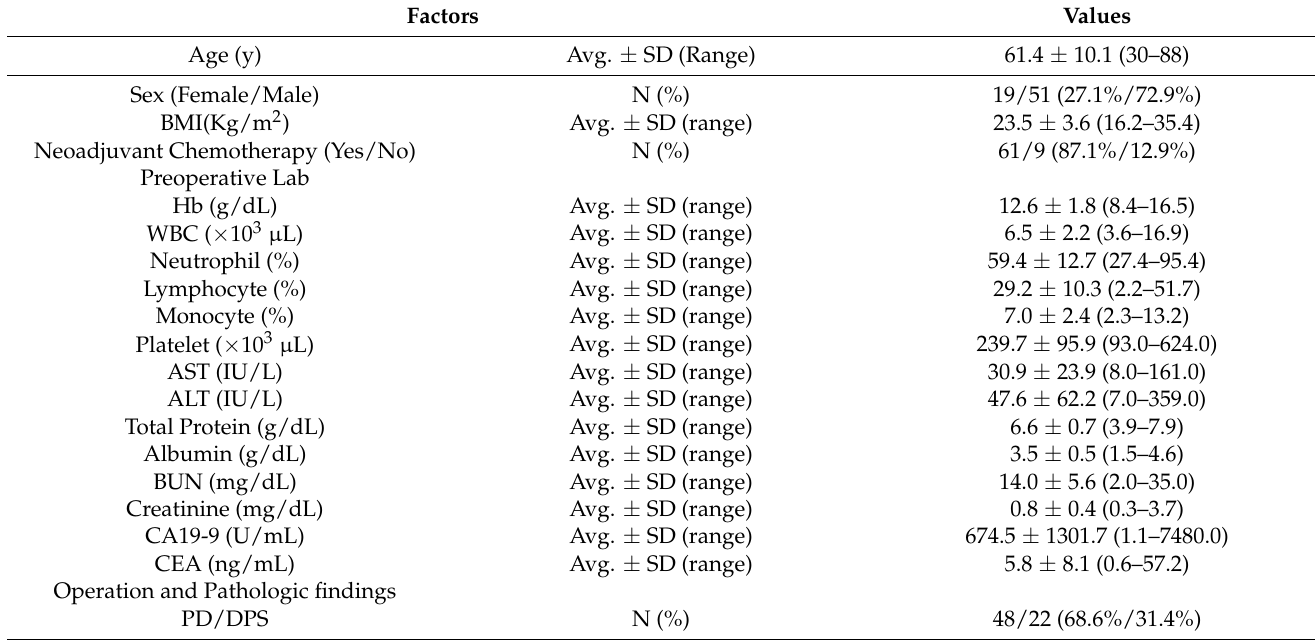
Table 1. Clinical information of the enrolled patients ( n = 70). (BMI: body mass index; Hb: hemoglobin; WBC: white blood cell; AST: aspartate aminotransferase; ALT: alanine aminotransferase; BUN: blood urea nitrogen; CA 19-9: carbohydrate antigen 19-9; CEA: carcinoembryonic antigen; PD: pancreaticoduodenectomy; DPS: distal pancreatectomy with splenectomy; wel: well; mod: moderate; por: poor; LVI: lymphovascular invasion; PNI: perineural